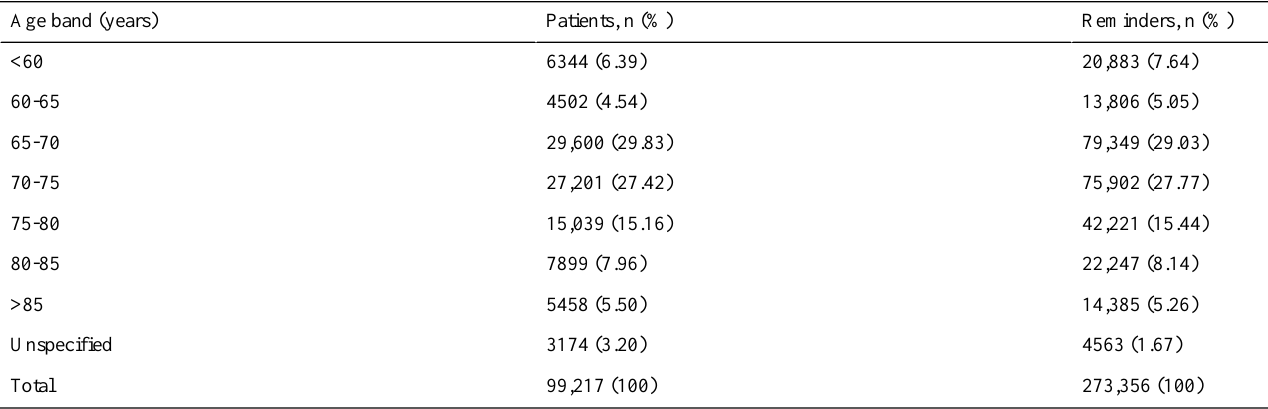
Table 1. Age of text messaging